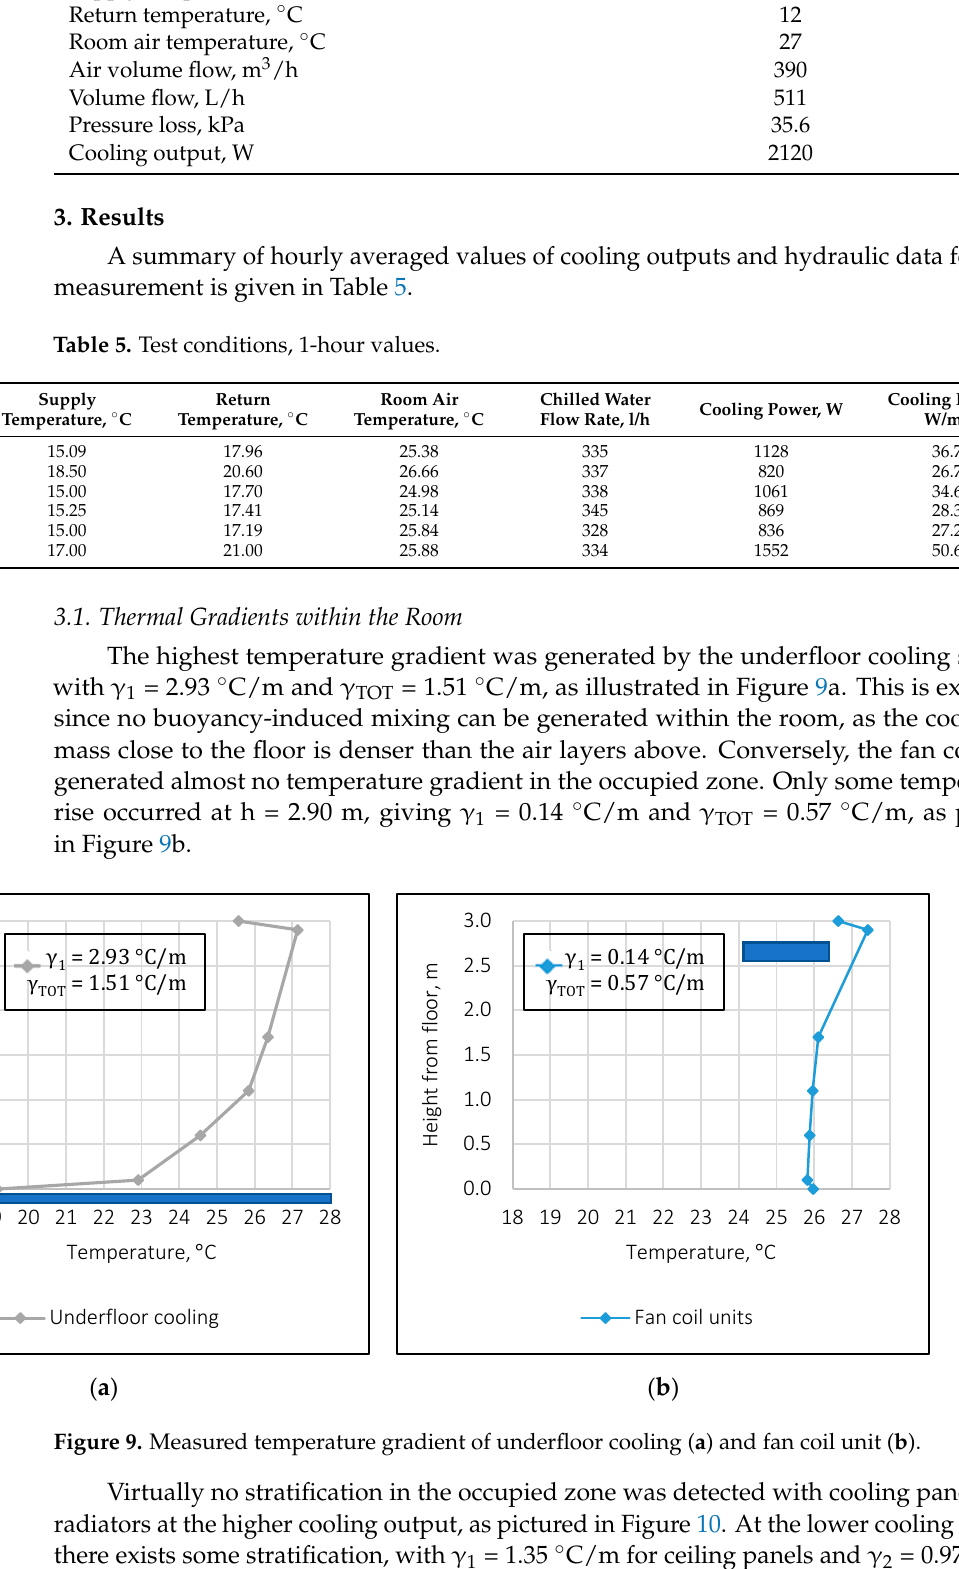
( a ) ( b ) Figure 10. Measured temperature gradient of ceiling panels ( a ) and panel radiators ( b ). 3.2. Operative Temperature Figure 11 portrays the measured difference between operative and air temperatures. This is overall quite substantial; a greater surface area (ceiling panels and underfloor cool- ing) is correlated with a larger difference, which can be as high as − 1.28 °C for ceiling panels measured at the lower cooling output. On the other hand, the opposite effect holds for the FCUs that provides t op − t 1.1 = 0.27 °C. For both ceiling panels and underfloor cooling, the lower cooling outputs have a higher temperature differential because the higher radiant heat exchange to the colder surface is offset by the lower temperature gradient.